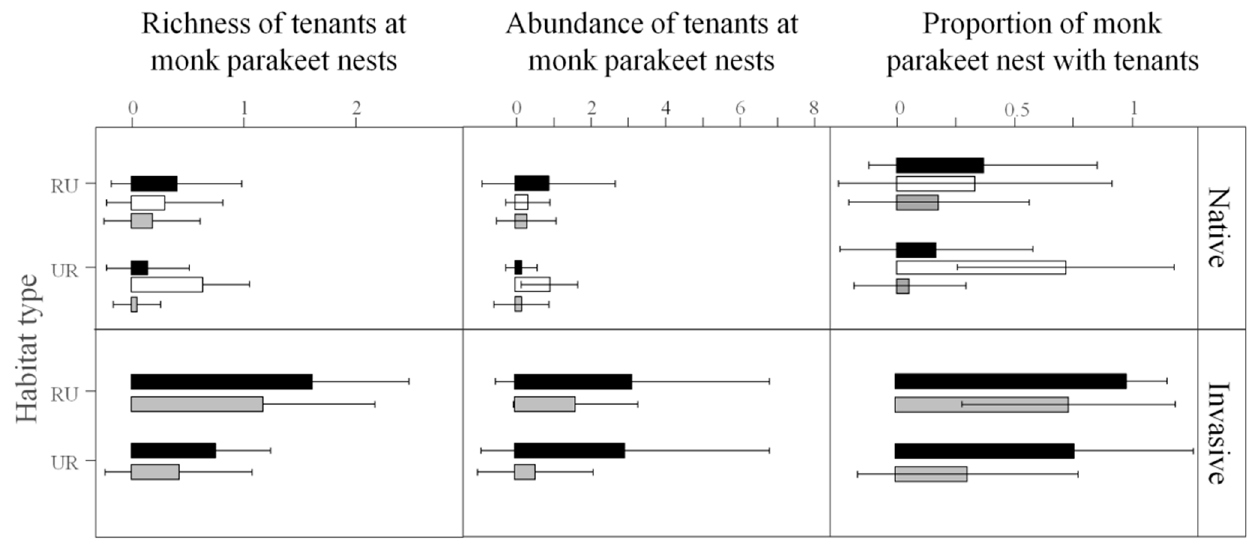
Figure 2. Proportion of nests (±SD) with tenants, and abundance (±SD) and richness (±SD) of tenants in the native and invasive populations of monk parakeets Myiopsitta monachus . Bars represent nests located in pylons (black bars), roofs (white bars), and trees (grey bars), grouped by urban (UR) and rural (RU) habitats. Table 3. Models obtained to assess the effects of different variables (see footer) on the persistence (years that a nest remained occupied) of tenants at monk parakeet nests. Estimates and 95% confidence intervals (2.5% and 97.5%) were obtained after model averaging. k : number of parameters, Δ AICc: difference between the AICc (i.e., the Akaike Information Criterion corrected for small sample sizes) of model i and that of the best model (i.e., the model with the lowest AICc), w : Akaike weights. The fit of the model including all variables used in model averaging can be checked in Figure S1. In bold, variables receiving strong support (i.e., the 95% confidence interval did not overlap with zero). The first ten models obtained are shown.